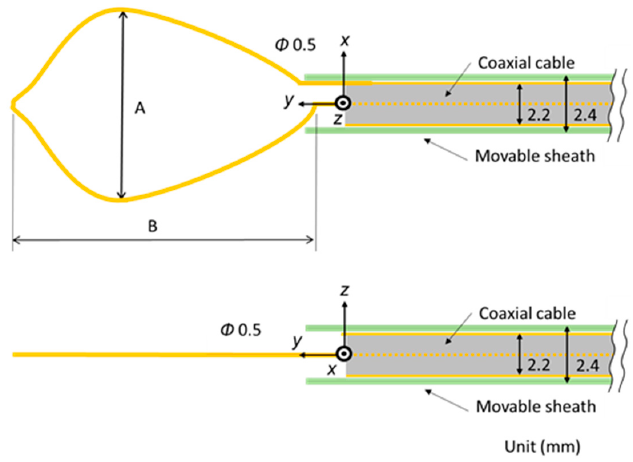
Figure 2. Schematic diagram of the proposed microwave snare. Diagnostics 2018 , 8 , x FOR PEER REVIEW